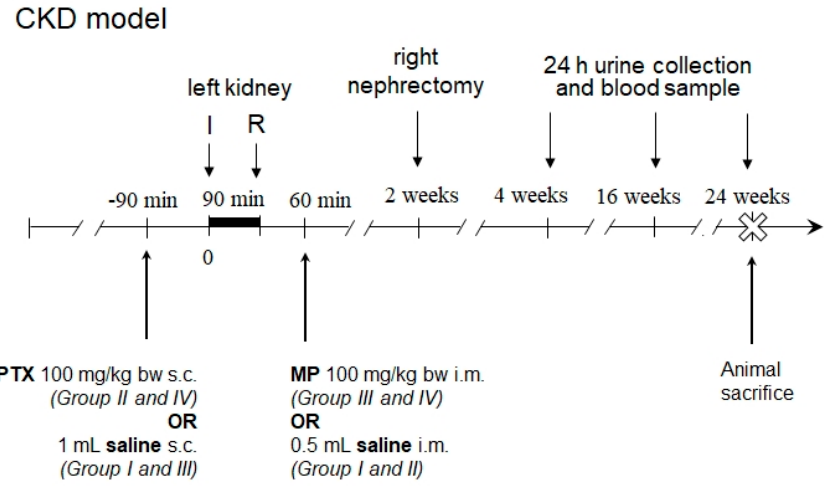
Figure 4. Scheme of the experiment of renal ischemia-reperfusion injury-induced chronic kidney disease (CKD). I—onset of ischemia; R—onset of reperfusion; PTX—pentoxifylline; MP—